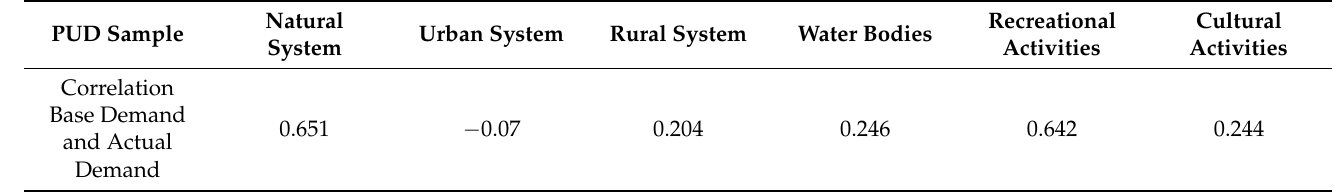
Figure 8. Density of photographs taken between 2009–2015 in both samples. Table 4. Correlation between MaxEnt model and actual demand by category in PUD